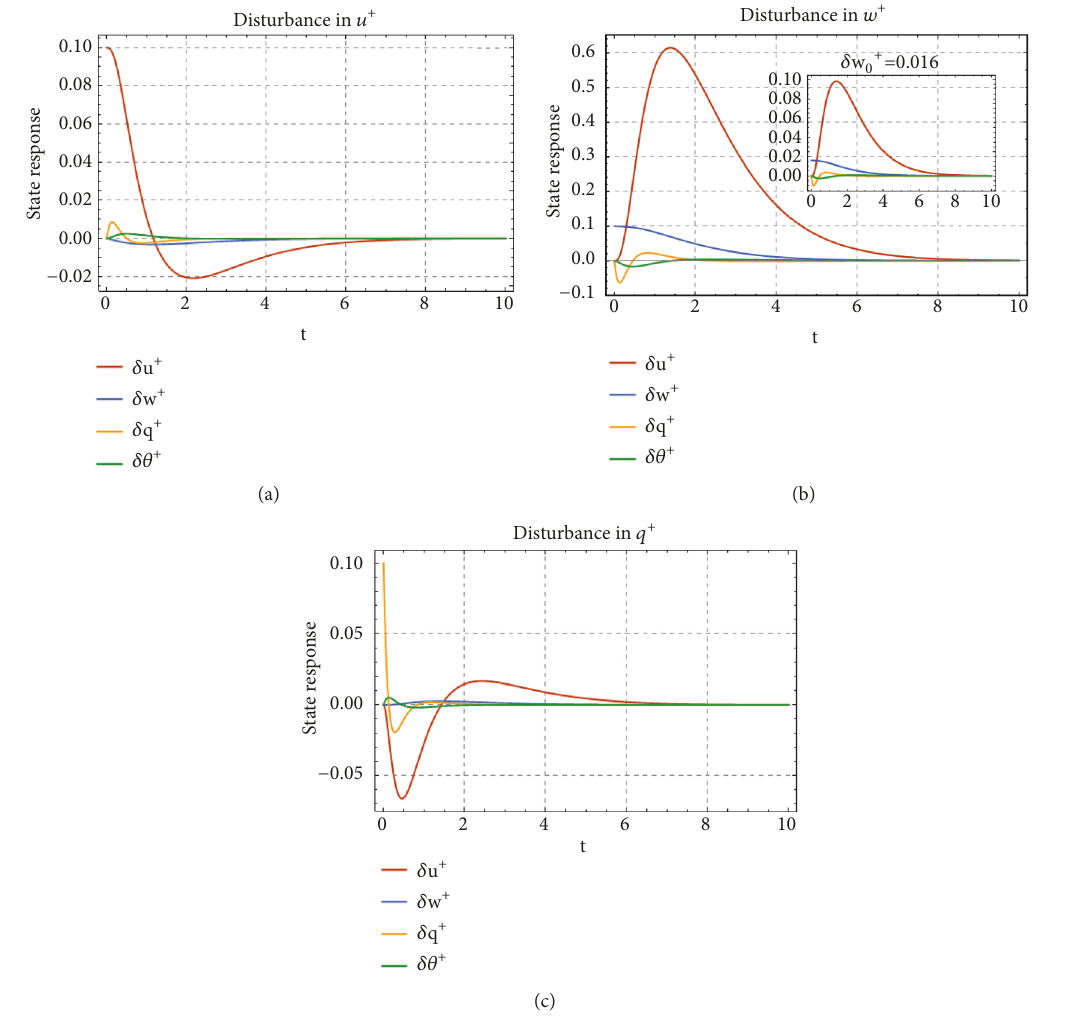
Figure 4: State response under disturbance of the state feedback control